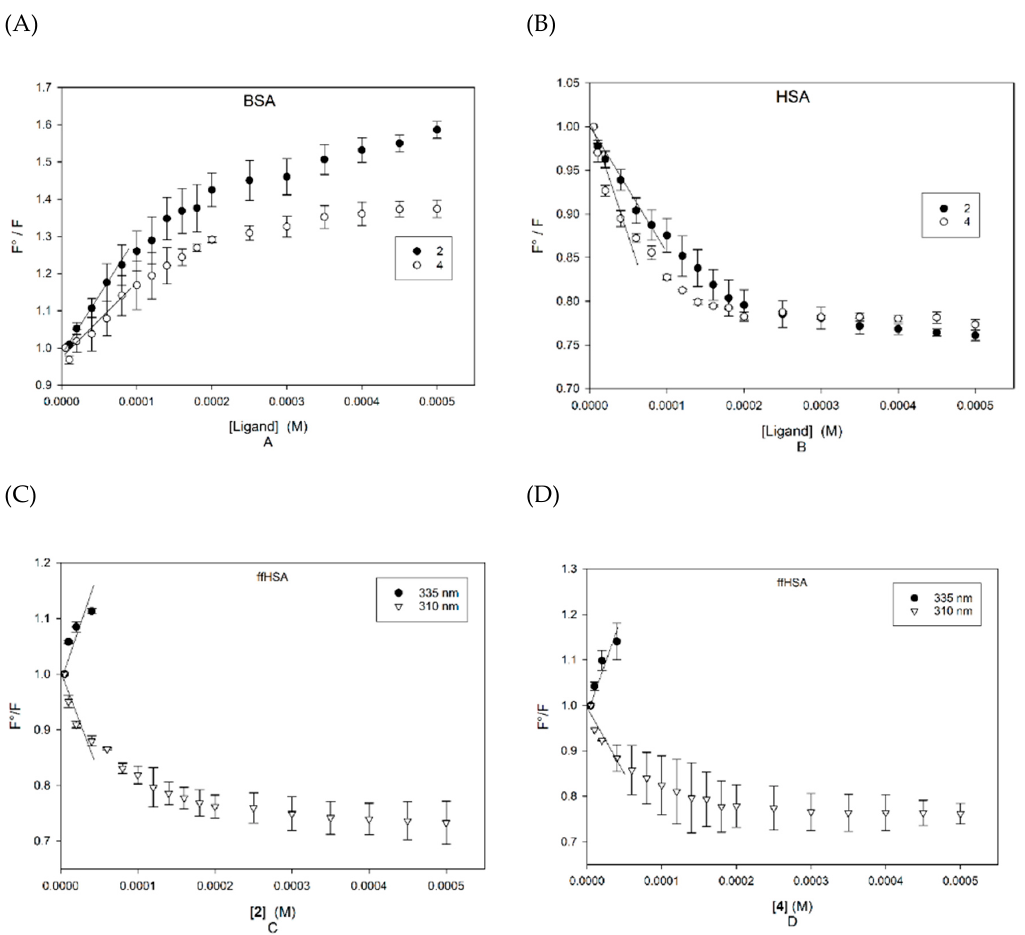
Figure 6. Stern–Volmer plots. ( A ): BSA emission at 340 nm upon addition of 2 (black) and 4 (white). ( B ): HSA emission at 330 nm upon addition of 2 (black) and 4 (white). ( C ): ffHSA emission at 335 (black) and 310 nm (white) upon addition of 2 . ( D ): ffHSA emission at 335 (black) and 310 nm (white) upon addition of 4 .